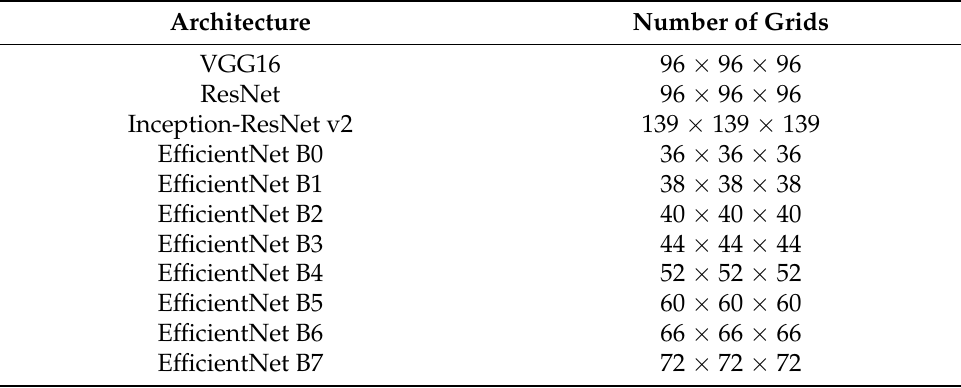
Table 3. Number of grids of each architecture used by the Voxel